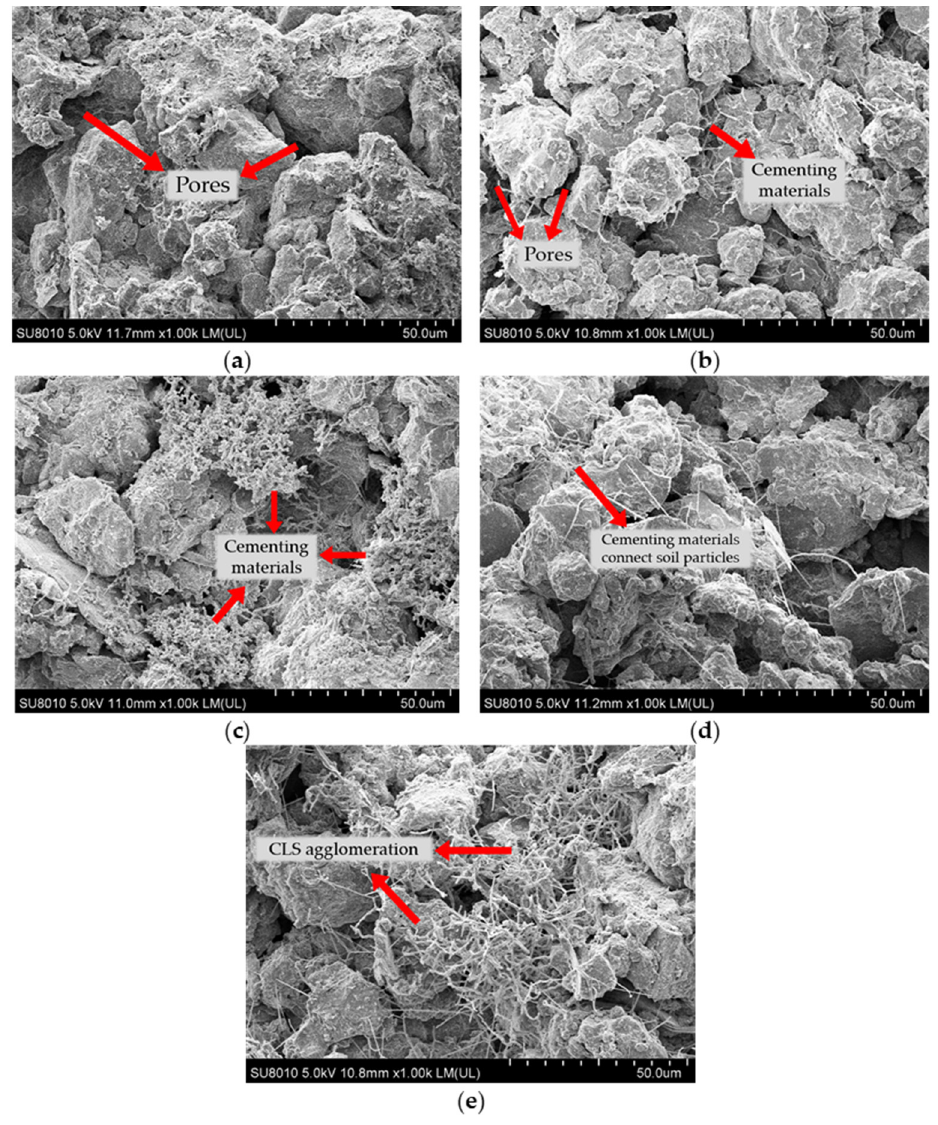
Figure 12. SEM of improved loess with different CLS content. ( a ) Untreated loess; ( b ) 1% CLS con- tent; ( c ) 3% CLS content; ( d ) 5% CLS content; ( e ) 7% CLS content. ( c ) 3% CLS content; ( d ) 5% CLS content; ( e ) 7% CLS